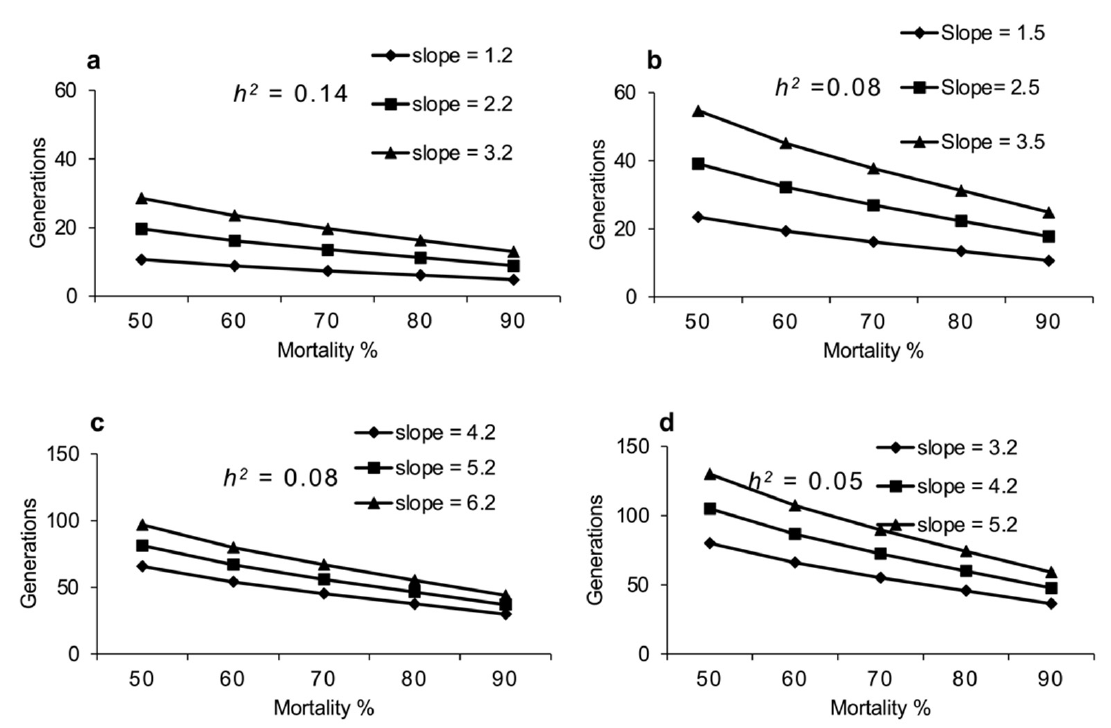
Figure 4. Effect of slope on number of generations of D. suzukii required for a 10-fold increase in LC 50 of female exposed to spinosad ( a ), male exposed to spinosad ( b ), female exposed to malathion ( c ) and male exposed to malathion ( d ) at different selection intensities (i).